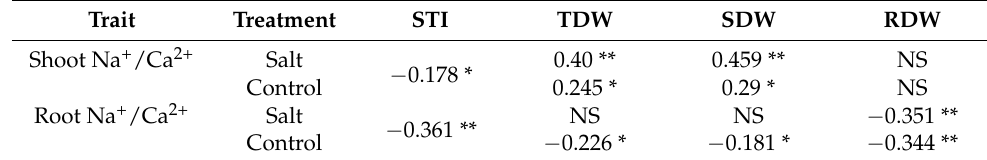
Table 2. Cont. Trait